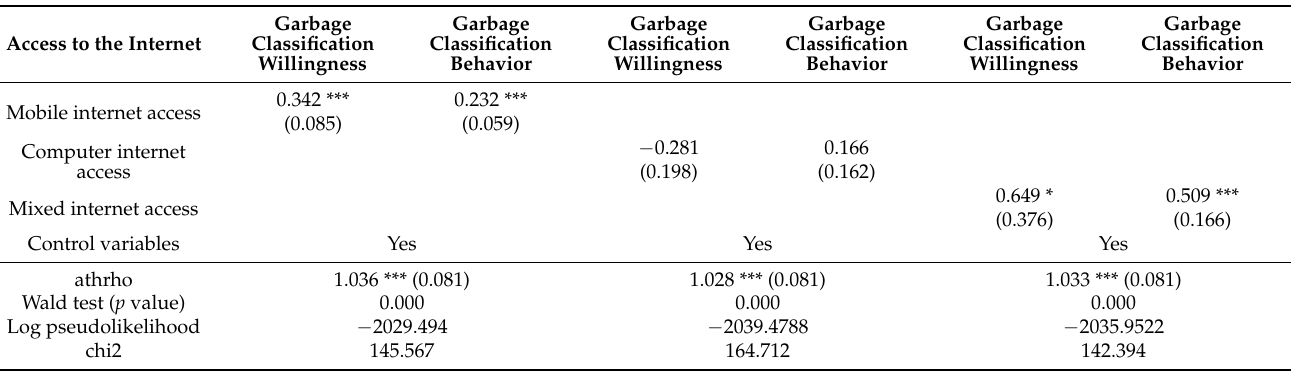
Table 6. Estimation results of the influence of different online ways on farmers’ willingness and behavior in relation to garbage